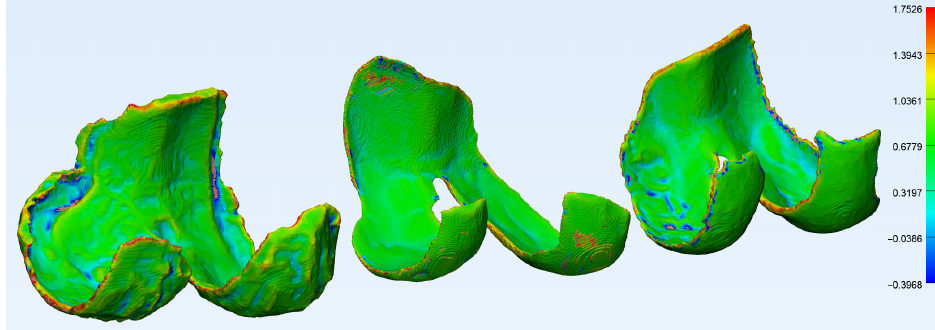
Figure 6. The curvature analysis of a femoral cartilage in 3-Matic, degenerative group ( left ), traumatic group ( center ) and control group ( right ).